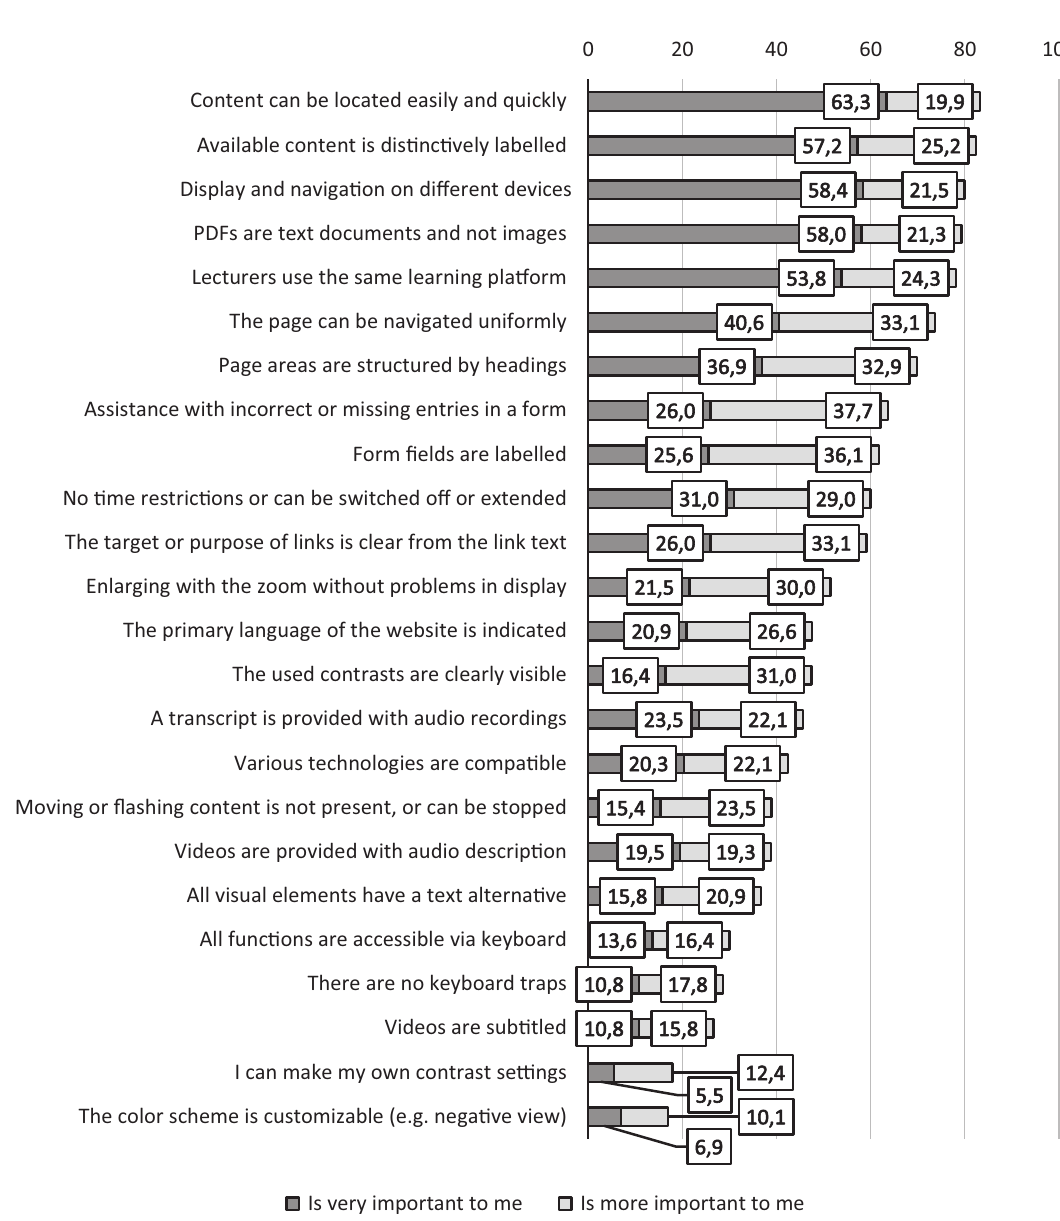
Figure 2. Importance of accessibility aspects (n = 507, in percent). Question: How would you rate the following statements in this context? When using e‐learning offerings, the following aspects are important to me…